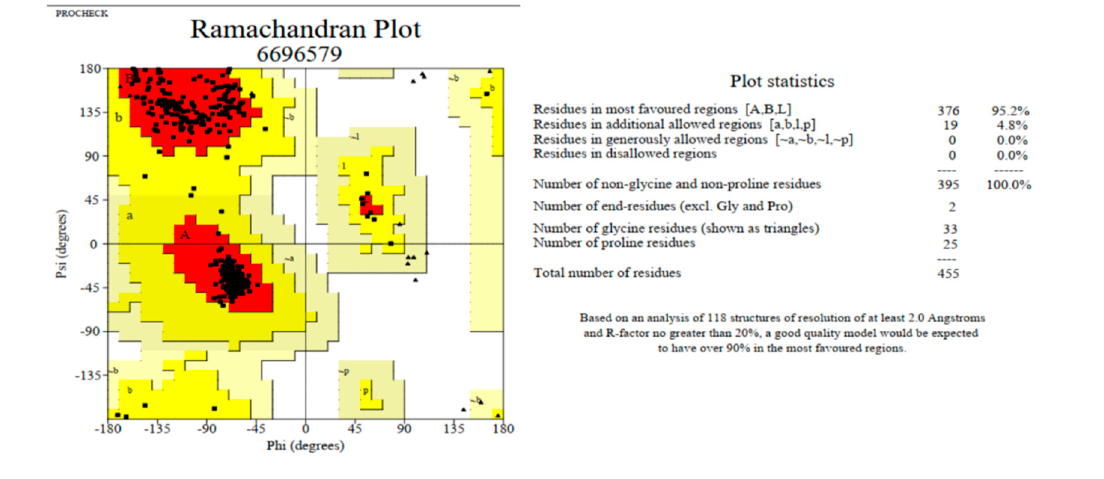
Figure 5. Ramachandran plot analysis of Modeller-predicted protein